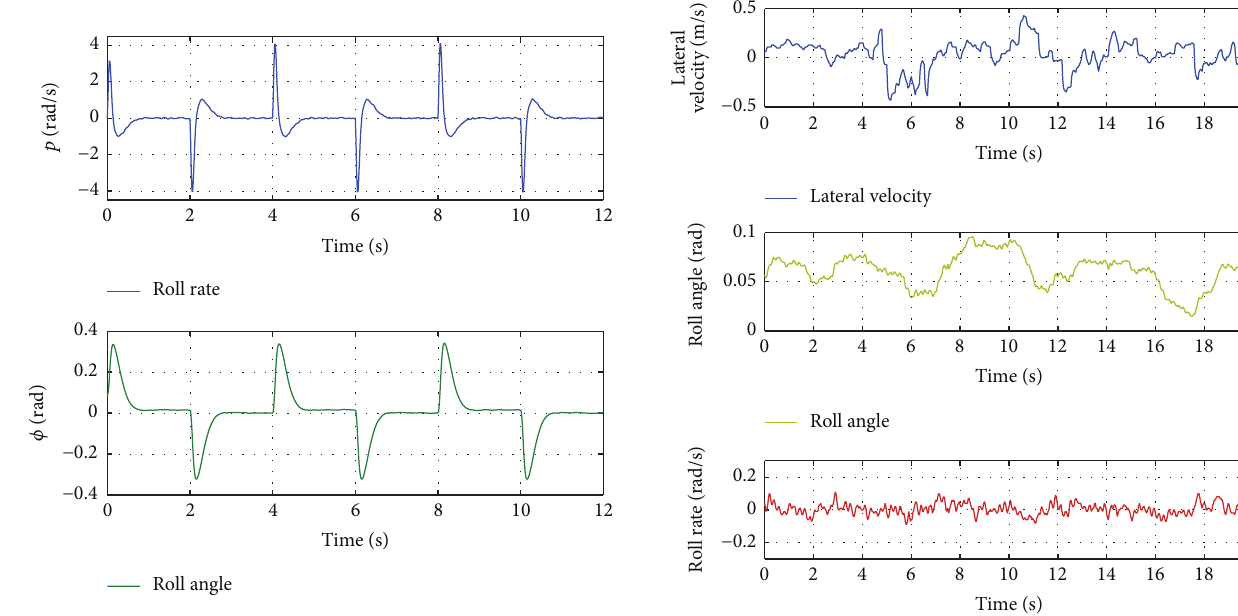
Figure 7: The performance of roll rate and roll angle.